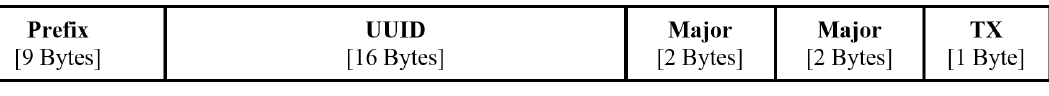
Figure 3. BLE beacon advertising packet